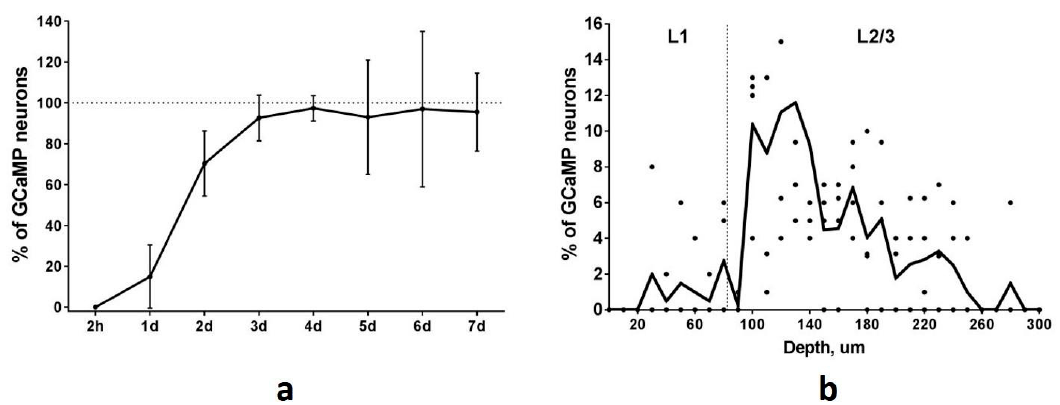
Figure 5. ( a ) GCaMP accumulation in the PtA neurons of Fos-Cre-GCaMP transgenic mice after cued fear learning. The total number of the GCaMP-positive neurons reached a maximum on the 4th day after training and remained at maximum level up to the 7th day ( n = 4, mean, 95% CI). ( b ) Depth distribution of the GCaMP-expressing neurons in the PtA. Dots show the individual values for each mouse.